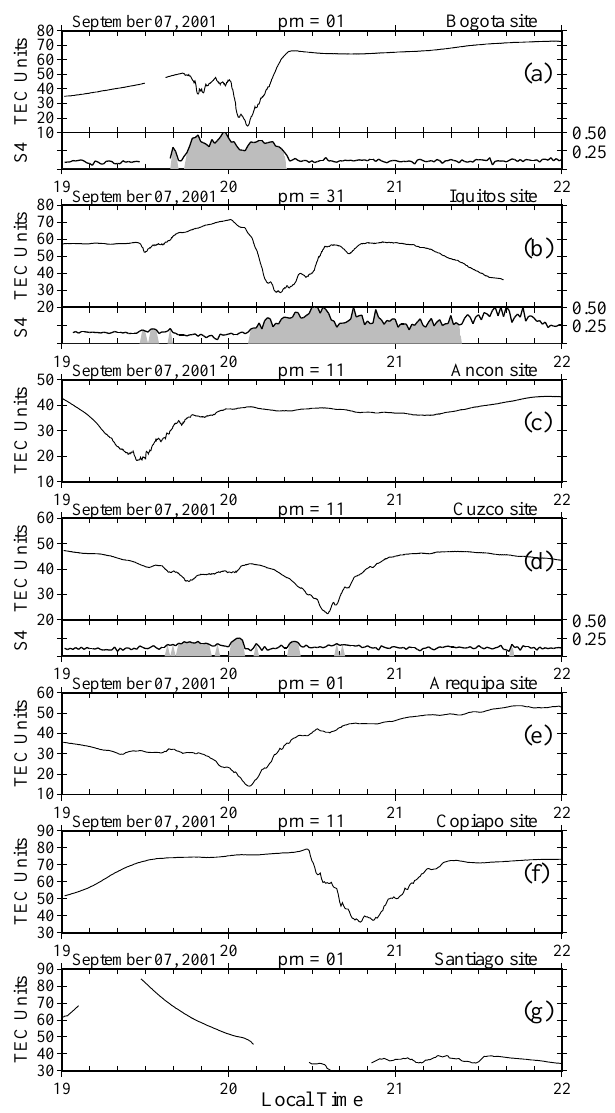
Fig. 2. Values of absolute TEC measured at several sites using sig- nals from 3 GPS satellites. In all of these passes TEC depletions are evident, sometimes exceeding 50 TEC units (10 16 el/m 2 ) . The additional sub-panel plotted below the Bogota, Iquitos and Cuzco TEC data corresponds to the S4 GPS scintillation index. Note that the minimum at Arequipa coincides with the minimum at Bogota, which is located ∼ 200km to the west. As the bubbles move to- ward the east, TEC depletions should be observed at Bogota tens of min ahead of Arequipa. This discrepancy can be explained by the westward tilt of the plumes. See text for